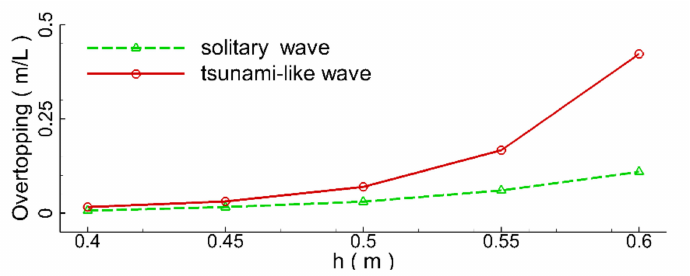
Figure 21. Variations in the maximum overtopping volume with the still water